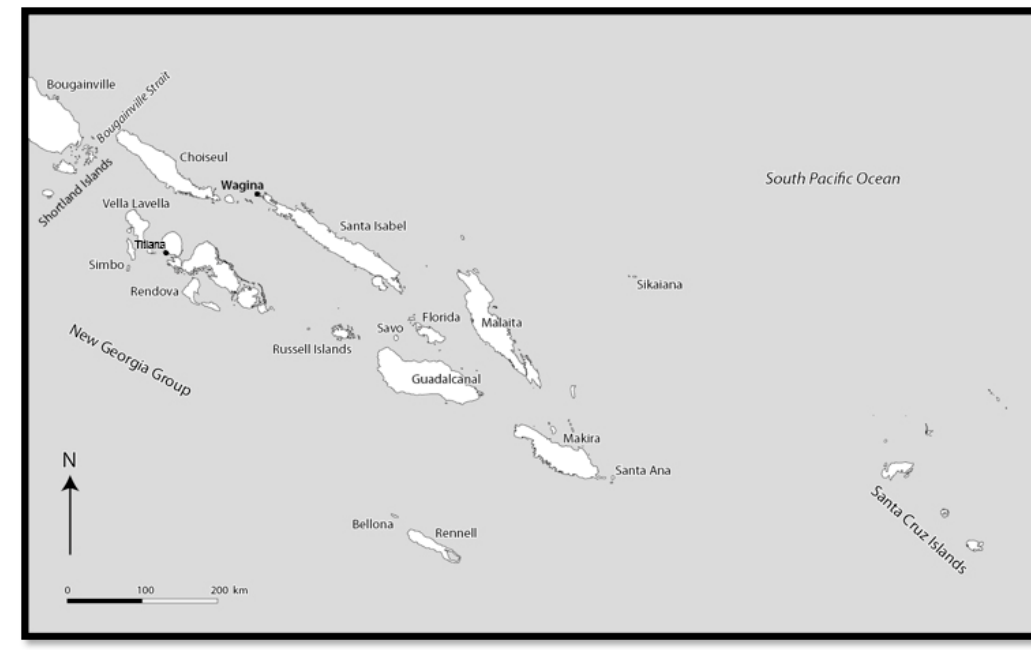
Figure 1. Map of Solomon Islands with the location of Wagina Island in the Southeast of Choiseul and Titiana on Gizo Island.